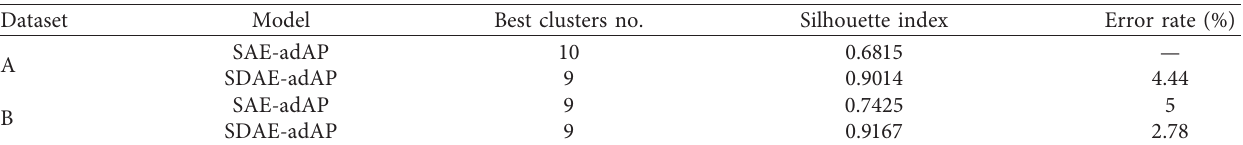
Table 6: The results of the best cluster number and classification error accuracy at the maximum Silhouette index value by using different models (the testing dataset).